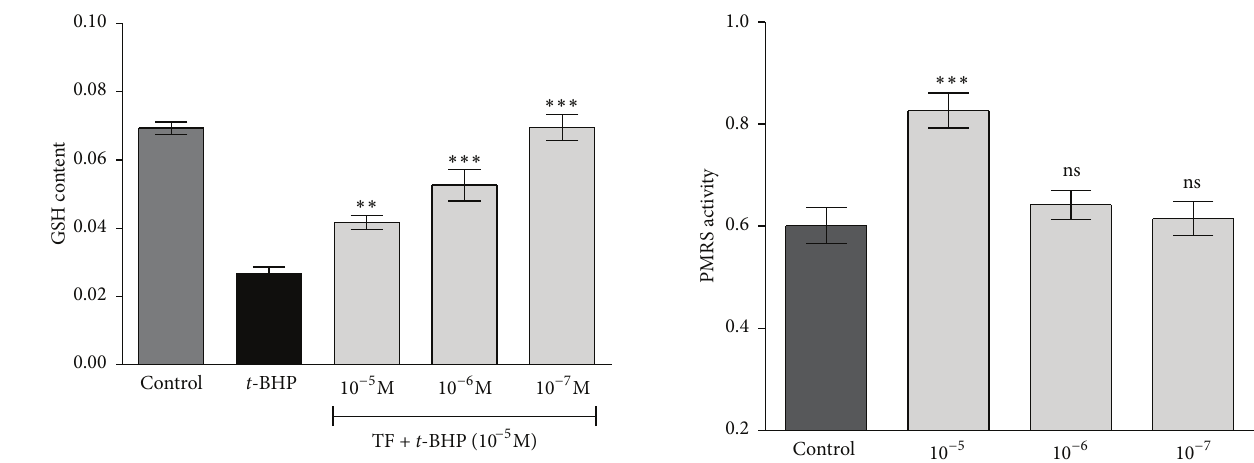
Figure 3: Concentration-dependent effect of black tea theaflavins on tert -butyl hydroperoxide- ( t -BHP-) induced changes in intra- cellular reduced glutathione (GSH) content in normal Wistar rat erythrocytes. The effect of theaflavins was evaluated on erythrocytes subjected to oxidative stress by incubation with t -BHP (10 −5 mol/L). Significant increase was observed in level of GSH. GSH content is expressed as mg/mL PRBCs. ∗∗ 𝑃 < 0.05 ; ∗∗∗ 𝑃 < 0.001 as compared with t -BHP treated.